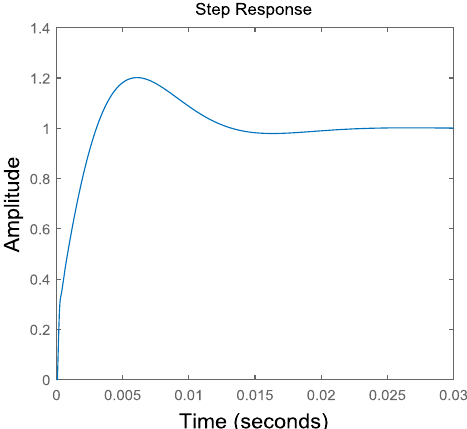
Figure 21. Step response of voltage closed-loop transfer function with set 3.